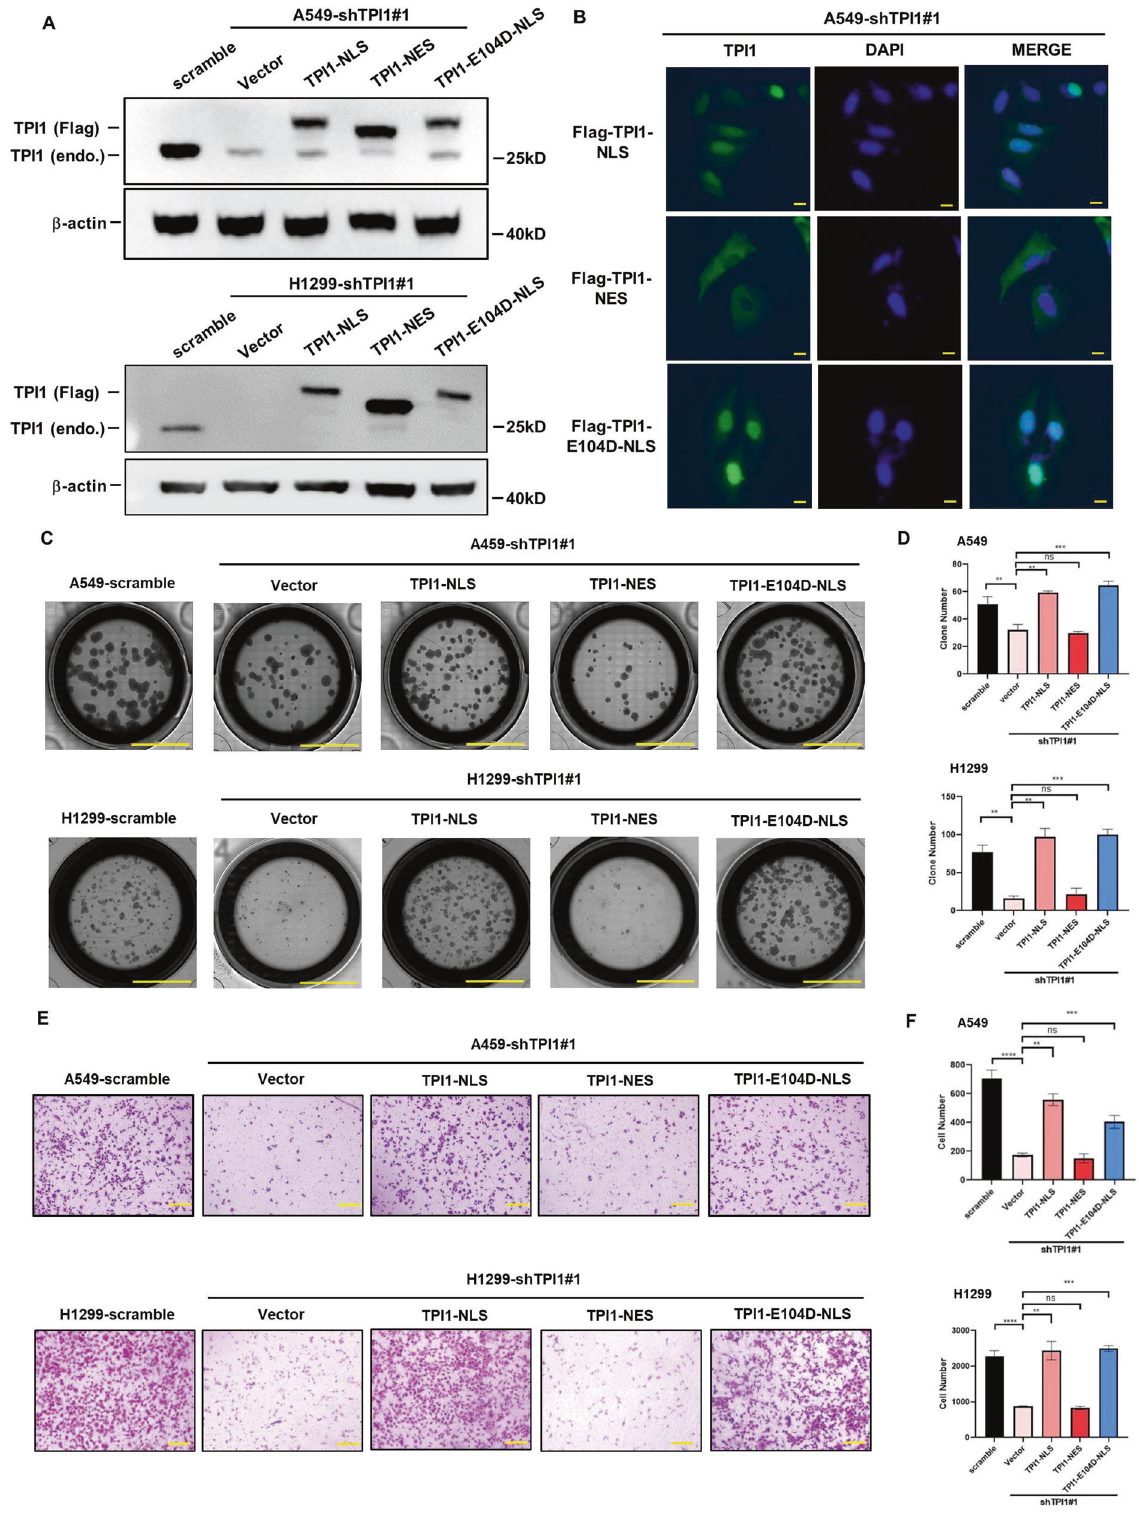
Fig. 5 Nuclear translocation of TPI1 promotes tumor cell migration and colony formation. A Validation of ectopic expression of TPI1-NLS, TPI1-NES, and TPI1-E104D-NLS in A549 and H1299 cells. B Validation of localization of TPI1-NLS, TPI1-NES, and TPI1-E104D-NLS in A549 cells by immuno fl uorescence staining. Scale Bar: 50 μ m. C TPI1 localized in nucleus rather than cytoplasm recovered colony formation ability of A549 and H1299 cells independent of enzymatic activity. D Bar graphs show the quantitative analysis data of colony formation assay in ( C ). Asterisks denote statistical signi fi cance with one-way ANOVA. ** p < 0.01; *** p < 0.001 for the indicated comparison. E TPI1 localized in nucleus rather than cytoplasm recovered migration ability of A549 and H1299 cells independent of enzymatic activity. F Bar graphs show the quantitative analysis data of transwell assay in ( E ). Asterisks denote statistical signi fi cance with one-way ANOVA. ** p < 0.01; *** p < 0.001; **** p < 0.0001 for the indicated comparison. Cell Death and Disease (2022)